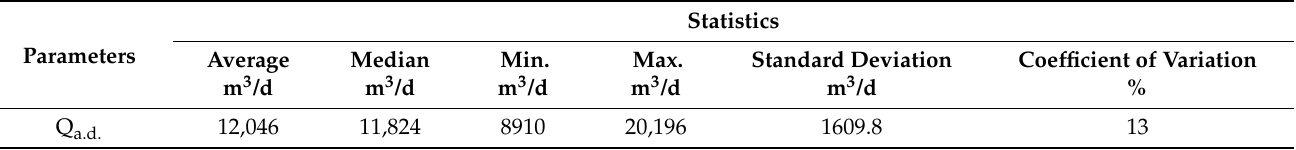
Table 2. Statistical characteristics of wastewater inflow Q a.d. in dry weather.